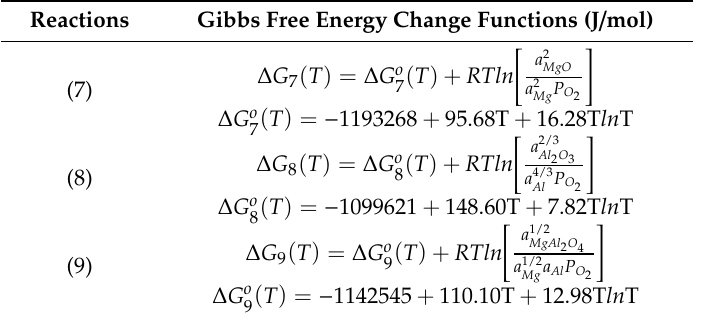
( T ) and the chemical activities a j of phases j , data i